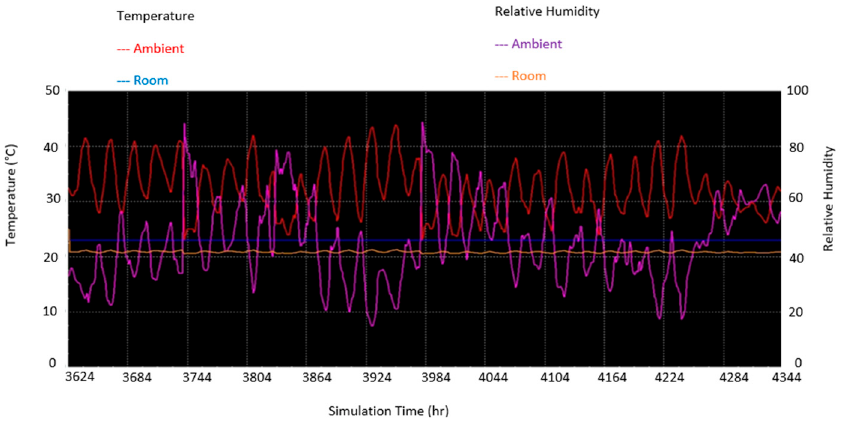
Figure 23. June simulation run for option C.